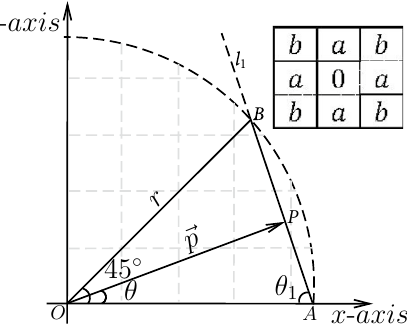
3 chamfer mask: l 1 , ( b ×